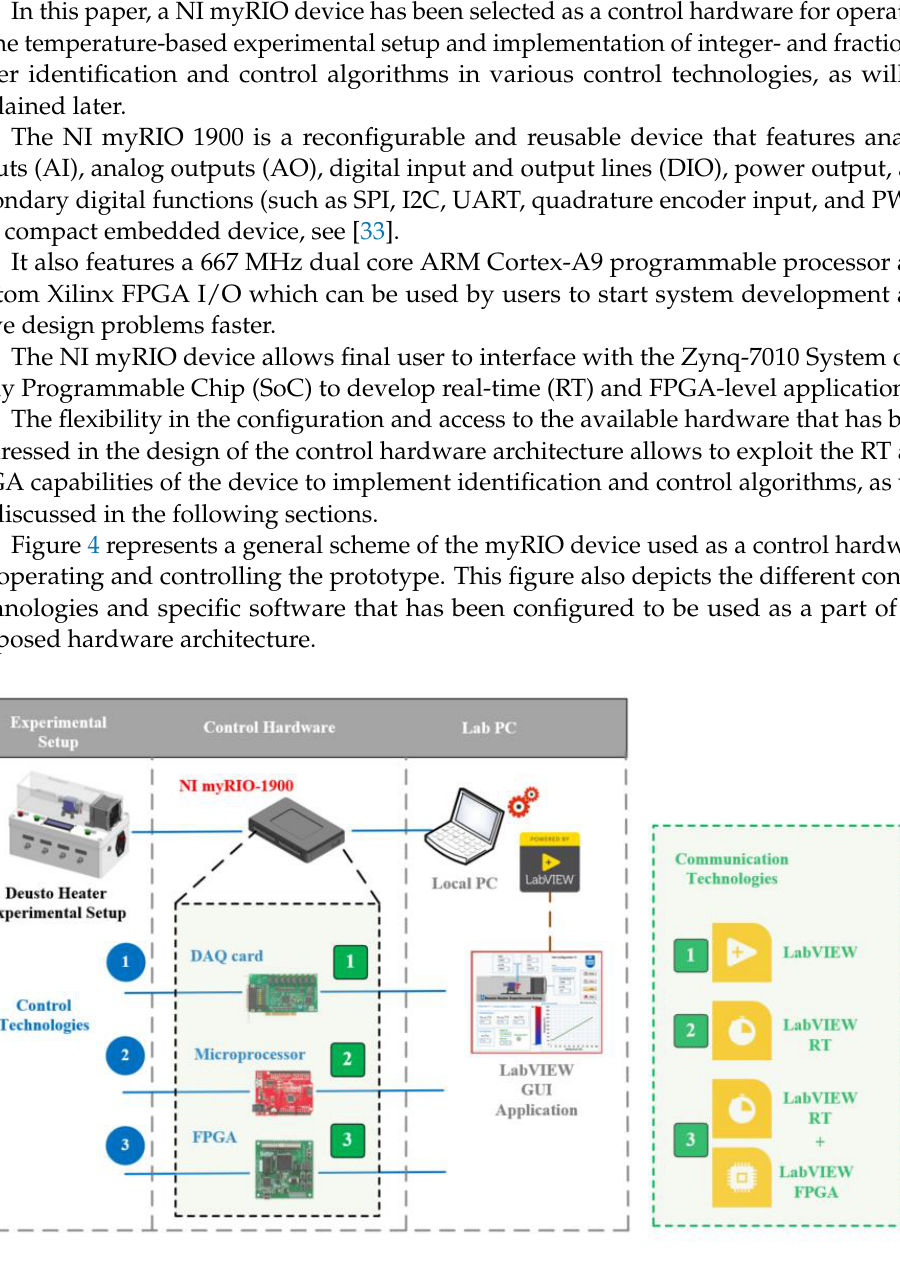
Figure 4. General scheme of the prototype using myRIO as a control hardware device. The different hardware technologies contained in the device and the software used are also depicted.